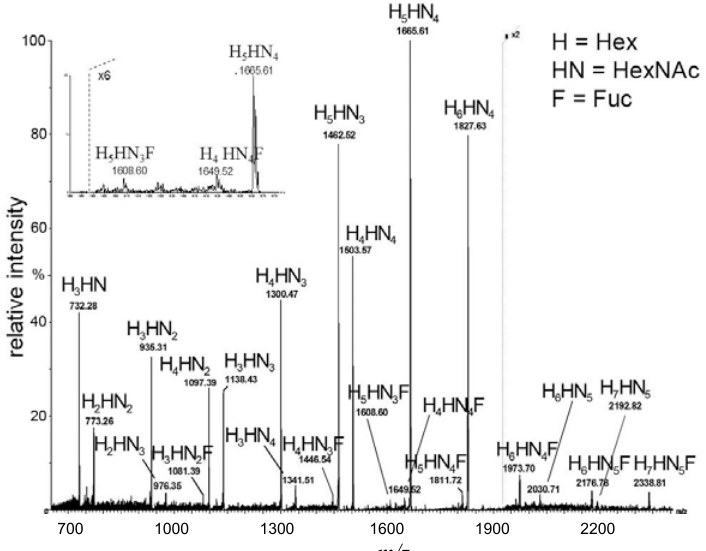
Figure 1. The (+) matrix-assisted laser desorption/ionization (MALDI) quadrupole-time-of-flight (Q-TOF) spectrum of the sample containing human milk oligosaccharide alditols. The m / z values represent [ M + Na ] +